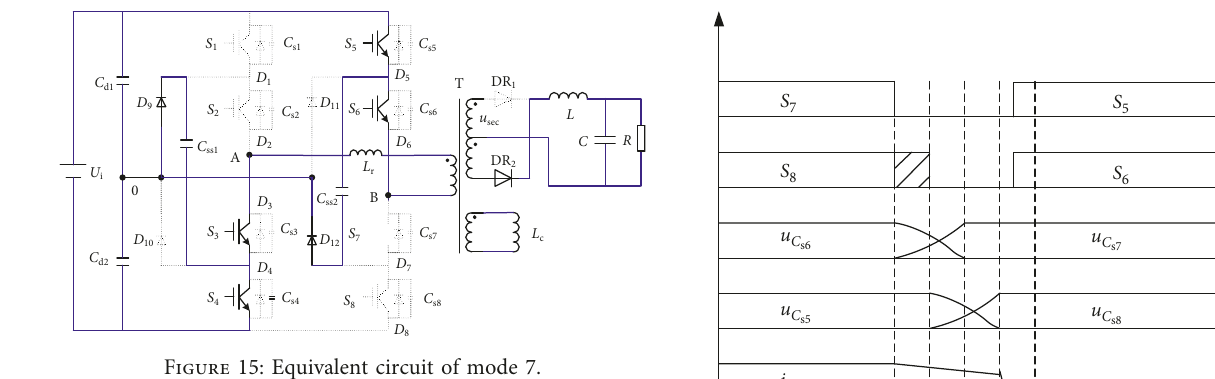
Figure 15: Equivalent circuit of mode 7.